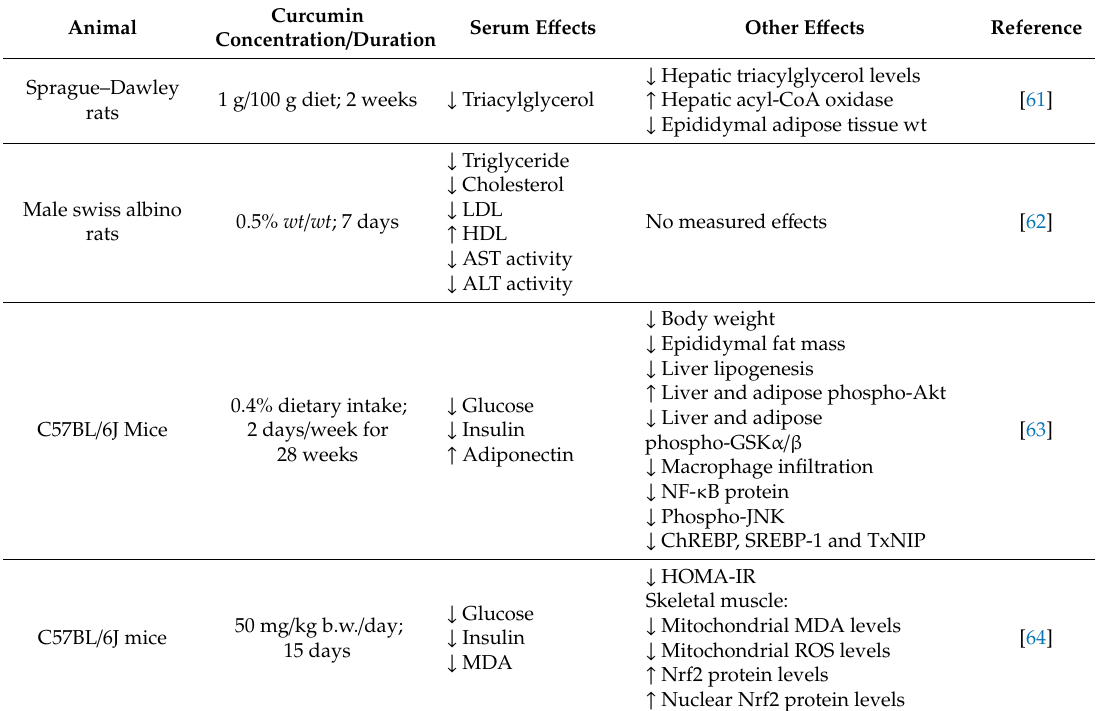
Table 4. Evidence of antidiabetic e ff ects of curcumin: in vivo diet-induced diabetes animal studies. Curcumin Animal Serum E ff ects Other E ff ects Concentration / Duration